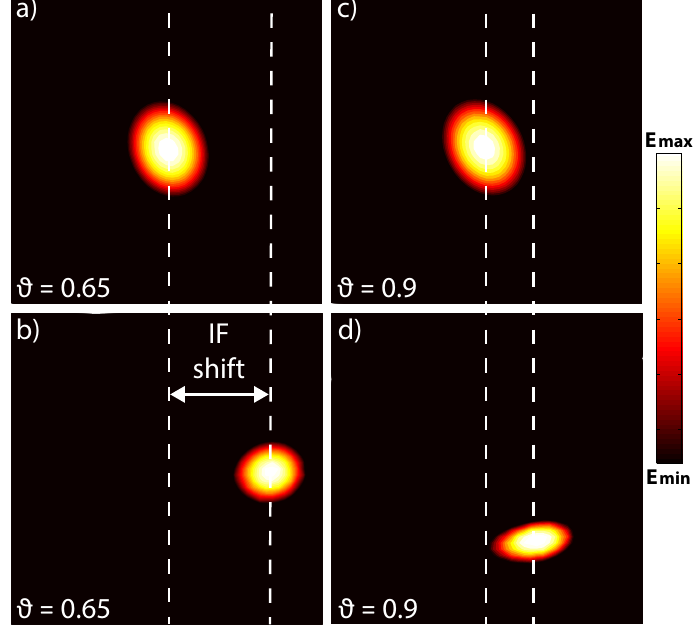
Figure 6. Simulated field distributions of the ( a , c ) incident and ( b , d ) reflected beam center at the angle of incidence ( a , b ) ϑ = 0.65 and ( c , d ) ϑ = 0.9 radians. Here, we consider the beam and material parameters presented in Figure 2b and working region 500 × 500 nm 2 within the uniaxial slab interface at the incident wavelength λ = 633 nm. The IF shift represents the lateral distance between the incident and reflected beam centers, and is 160 nm for ϑ = 0.65 and 65 nm for ϑ = 0.9 radians, respectively. Pronounced Goos-Hänchen shift of 150 nm occurs for ( d